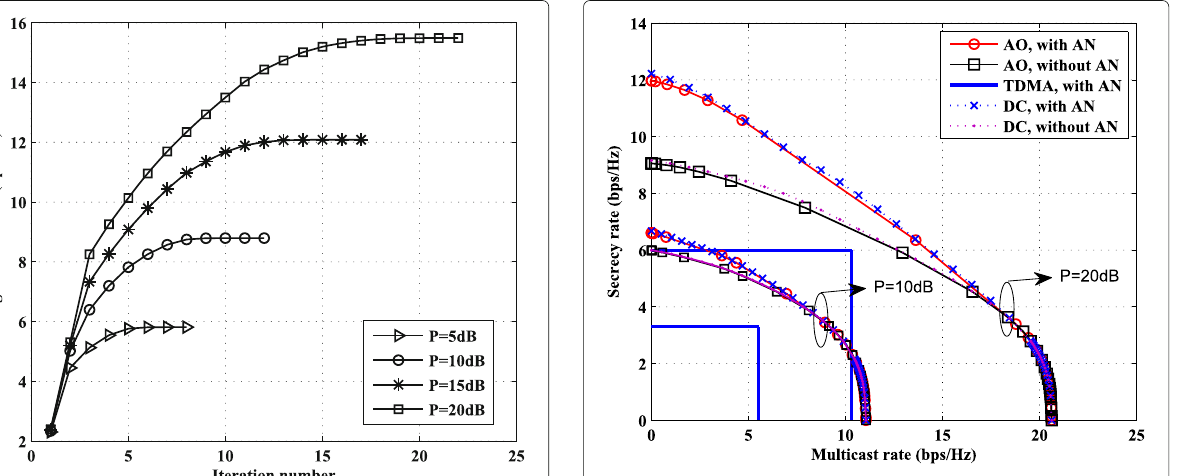
R 0 increases. This phenomenon agrees with our conjec- ture in Section 5.1. The second observation is that our proposed strategies, though only attain a lower bound on R s ( { H k } k ∈ K , P ) , is sufficient to achieve significantly larger secrecy rate regions than the TDMA-based